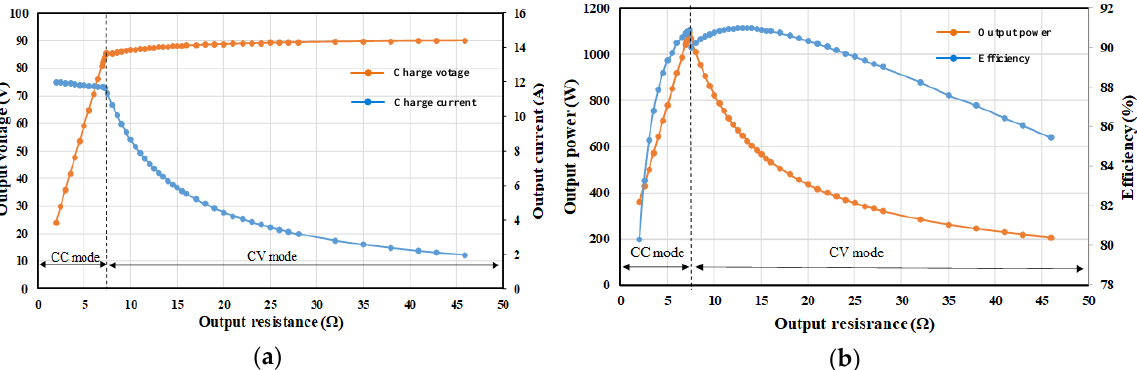
Figure 15. Measured charging process under dynamic loads. ( a ) Charging diagram; ( b ) charging efficiency and output power.